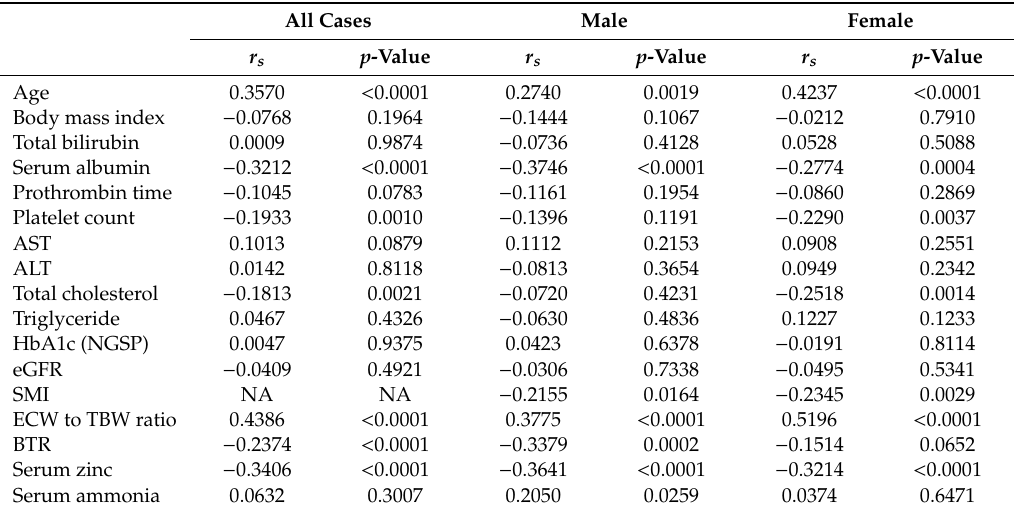
Table 2. Correlation between frailty score (0–5) and baseline numerical variables.